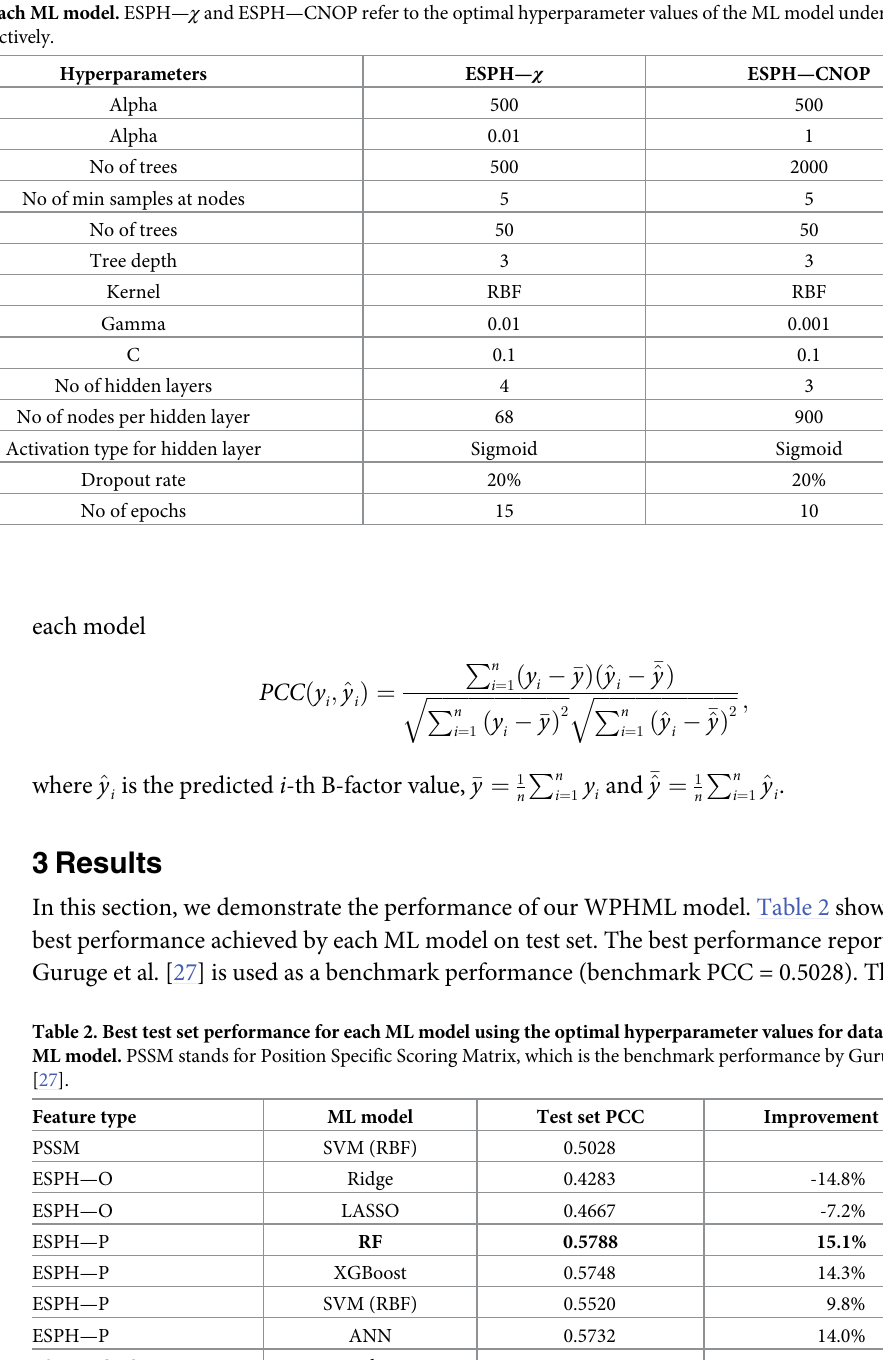
Table 1. Optimal hyperparameter values for each ML model. ESPH— χ and ESPH—CNOP refer to the optimal hyperparameter values of the ML model under single-ele- ment and four-element-combined dataset respectively. ML model